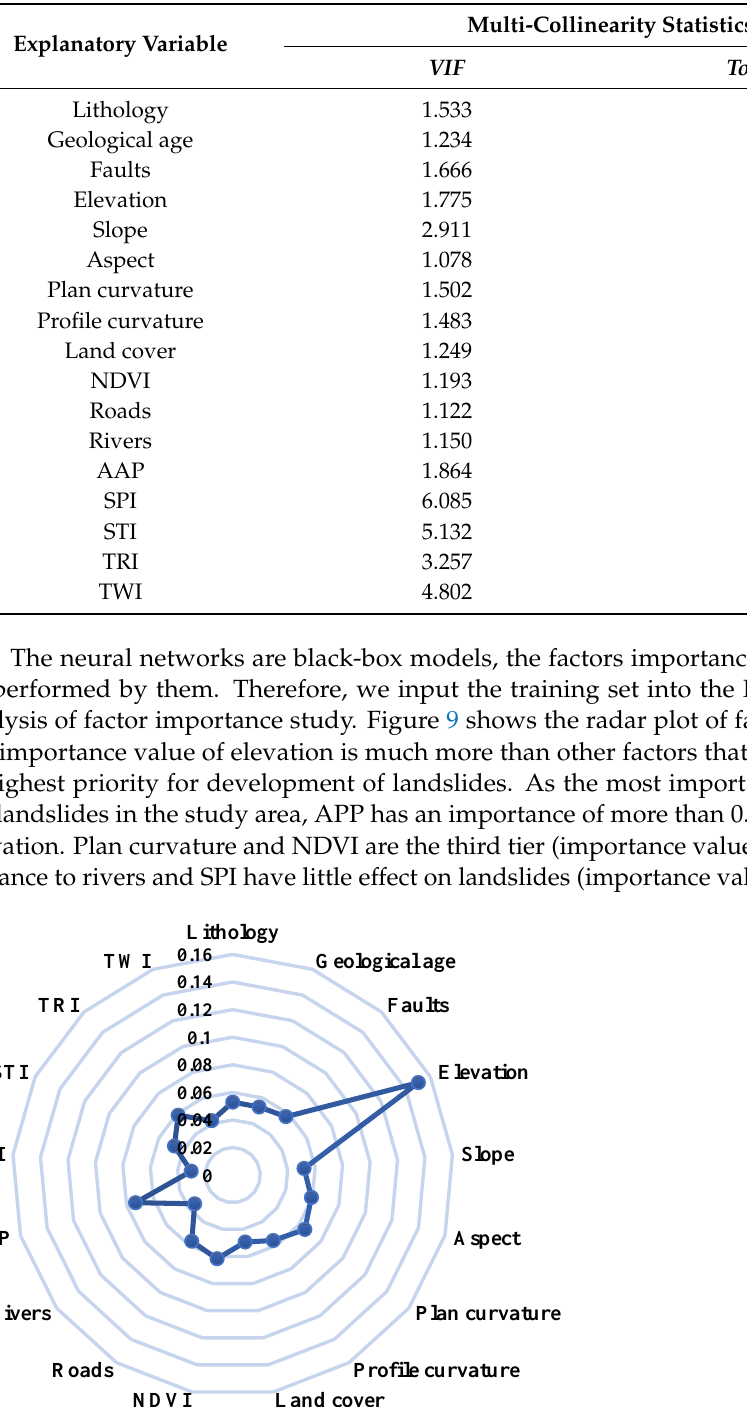
Table 3. Multi-collinearity analysis results of explanatory variables.